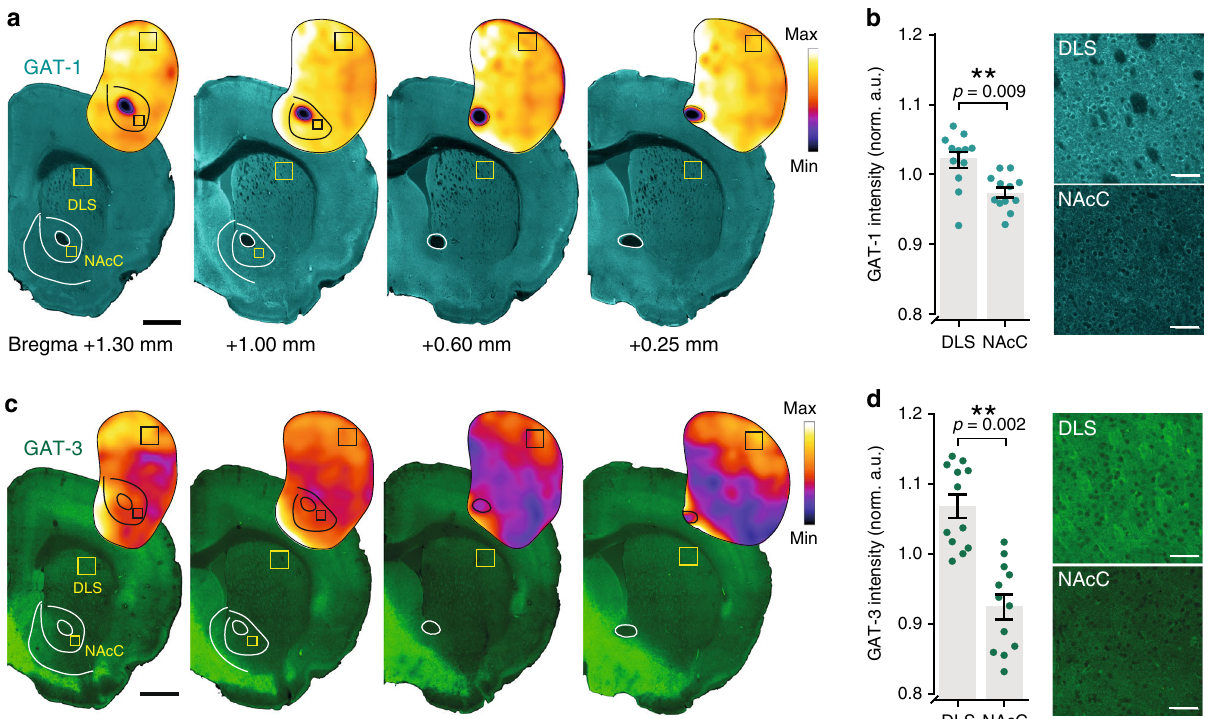
Fig. 4 Enrichment of GAT-1 and GAT-3 expression in the DLS versus NAcC. a , c Representative immuno fl uorescence signals for GAT-1 (cyan, a ) and GAT-3 (green, c ) using confocal microscopy in coronal sections across the rostral-caudal limits containing striatum prepared from an individual C57BL/6J mouse with heatmaps for striatal GAT intensity. Boxes indicate representative locations for GAT intensity measurements in the dorsolateral striatum (DLS) and nucleus accumbens core (NAcC). Scale bars: 1 mm. Note enriched GAT-3 in the medial NAc shell contiguous with the medial septal nucleus and enriched GAT-3 expression in the claustrum. b , d Left, Mean GAT-1 ( b ) and GAT-3 ( d ) intensity in DLS and NAcC normalized to total striatum and averaged across rostral-caudal sites for each hemisphere ( n = 12 hemispheres/6 mice for each GAT-1 and GAT-3). Right , Representative single plane images of GAT-1 ( b ) and GAT-3 ( d ) immuno fl uorescence from DLS and NAcC; imaging parameters were kept constant across regions. Scale bars: 50 μ m. Mann – Whitney U tests ( b , d ). ** p < 0.01. Error bars are ±SEM. Source data are provided as a Source Data fi